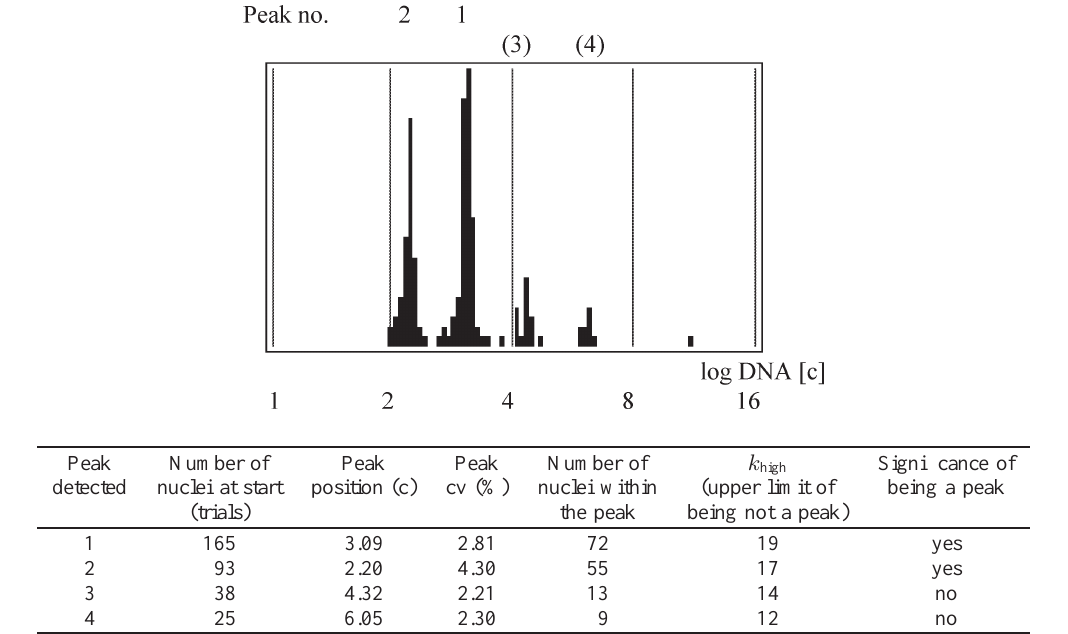
Fig. 5. DNA histogram of a breast cancer with obviously 4 “spikes”. Two of them are defined statistically as peaks. The details of the statistical figures are given below the